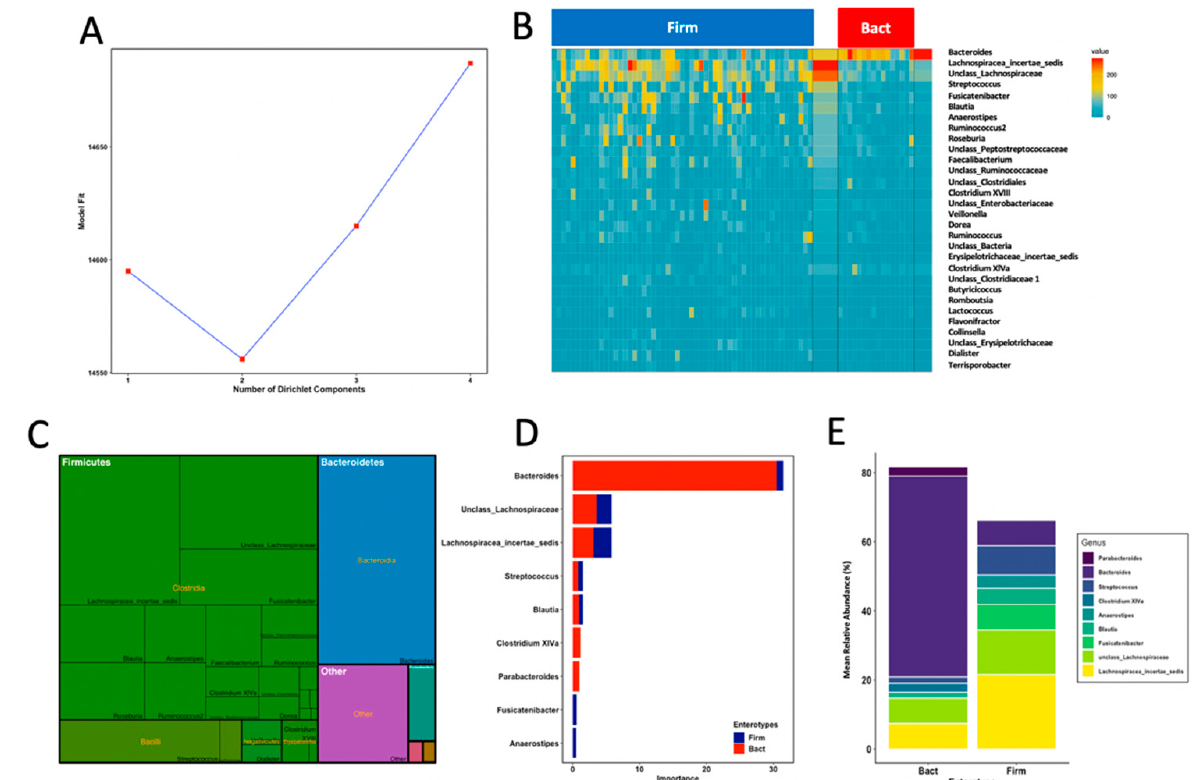
Figure 2. Probabilistic modelling with Dirichlet multinomial mixtures of faecal samples revealed 2 enterotypes in 71 full-term healthy infants at 18 months of age. ( A ) The model was fit to k = 4 and rendered the lowest model fit value of Laplace approximation for four components which was taken as evidence for the presence of the two main community types. ( B ) Heatmap showing the relative abundance of the 30 most dominant genera per DMM enterotype. Abundance represents square root sequence reads. ( C ) Contribution of the 30 most dominant genera to overall community composition. ( D ) Contribution to model prediction of microbial core genera to each enterotype. ( E ) Contribution of core signature genera (mean relative abundances) to microbial profiles in each DMM enterotype.